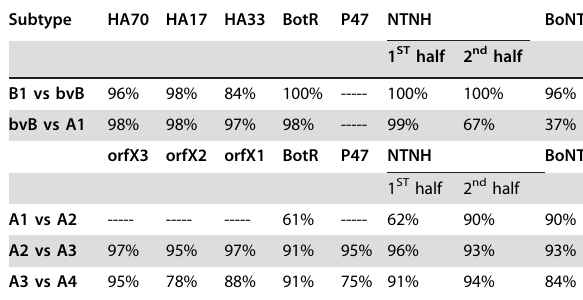
Table 1. Comparison of amino acid identities between